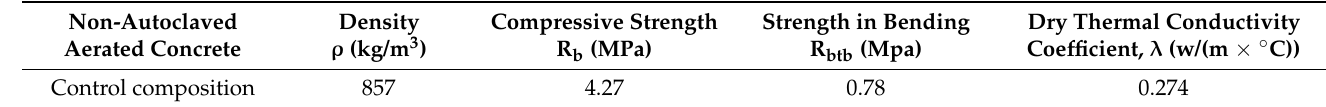
Table 10. Physical and mechanical characteristics of non-autoclaved aerated concrete of the control composition.